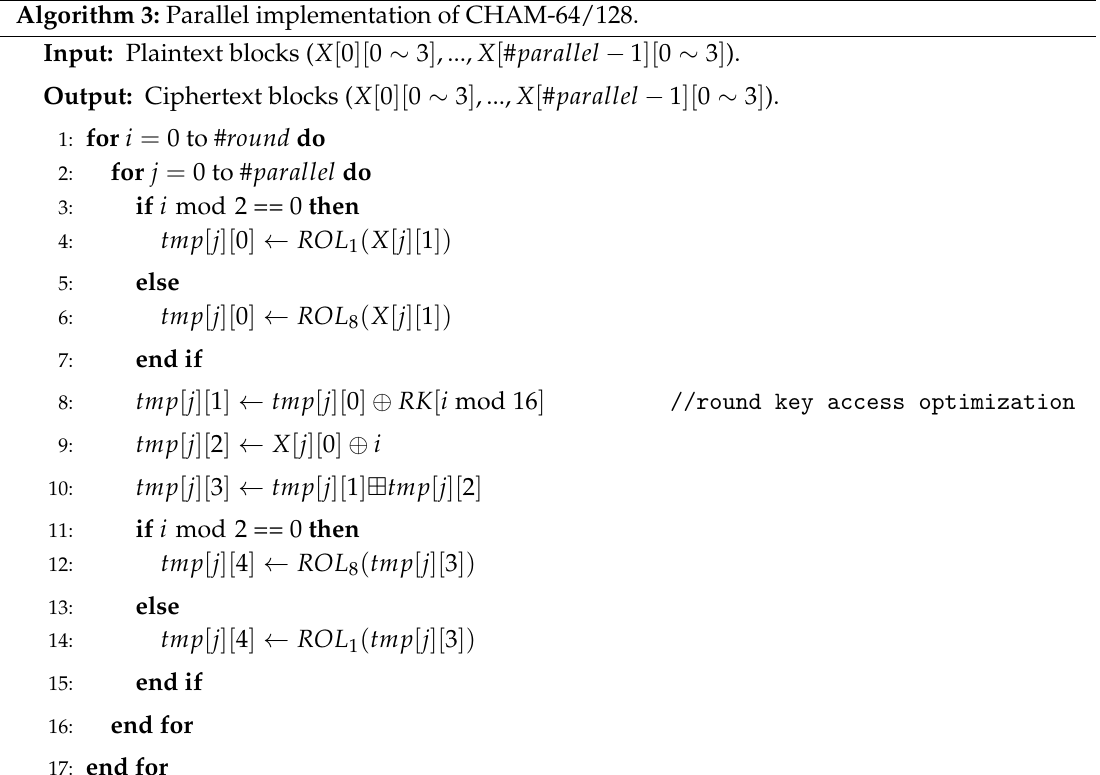
Algorithm 3: Parallel implementation of